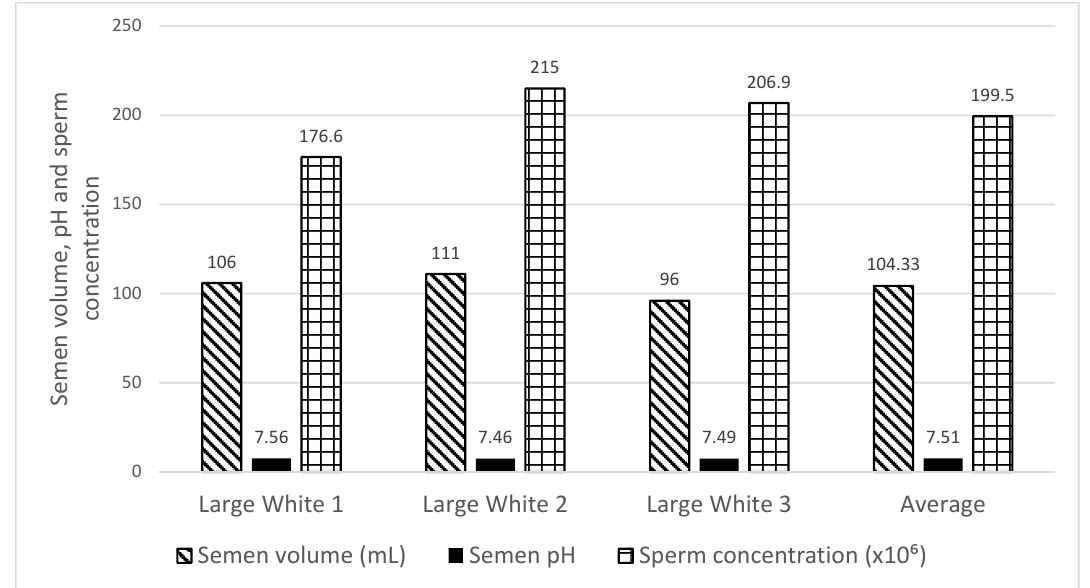
Figure 2. Characterization of semen volume, pH, and sperm concentration in Large White boars. Table 2. Evaluation of sperm motility and velocity traits of fresh semen from Large White boars.